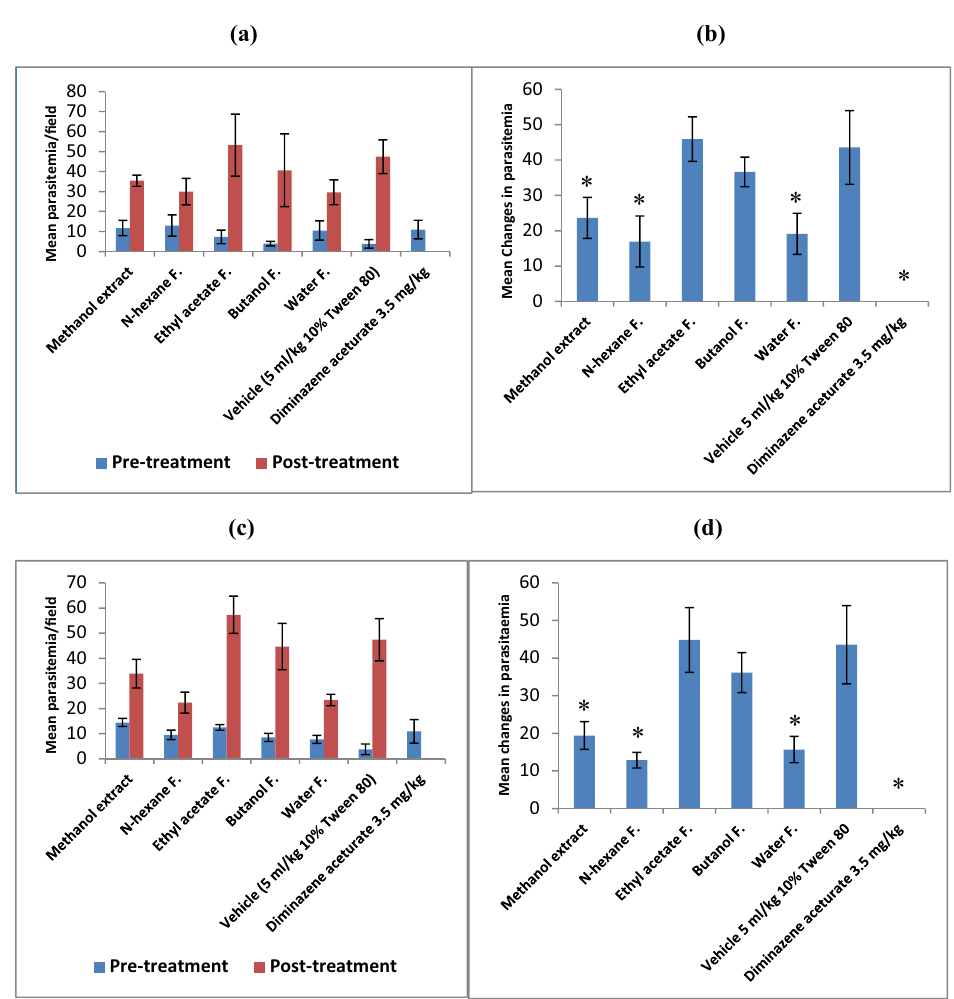
Figure 1: E ff ect of the extract and fractions on the parasitemia of T. brucei brucei - infected animals. ( a ) 200 mg/kg extract and fraction e ff ect on mean parasitemia; ( b ) 200 mg/kg extract and fraction e ff ect on mean changes in parasitemia; ( c ) 400 mg/kg extract and fraction e ff ect on mean parasitemia; and ( d ) 400 mg/kg extract and fraction e ff ect on mean changes in parasitemia. * P < 0.05 compared to the vehicle - treated control